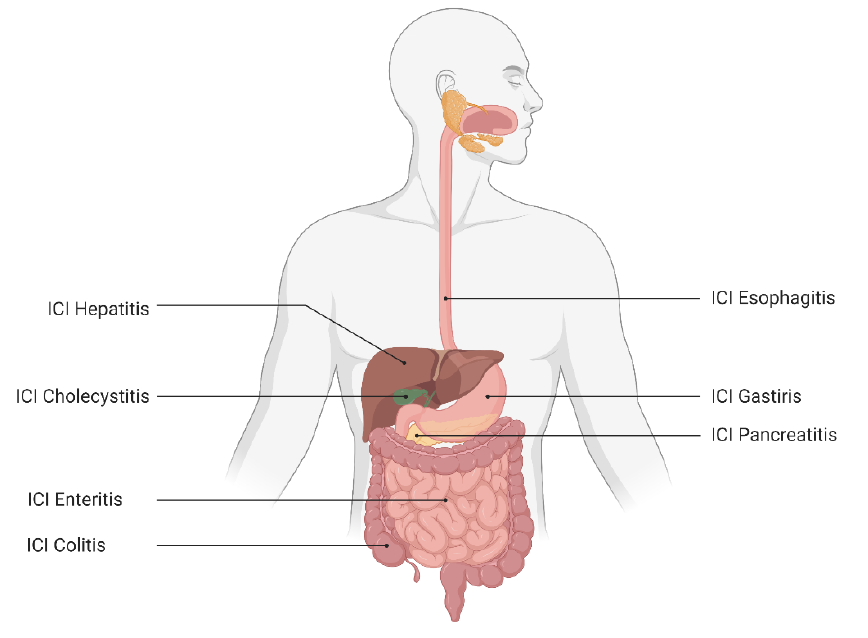
Figure 1. The irAEs of the gastrointestinal immune system.